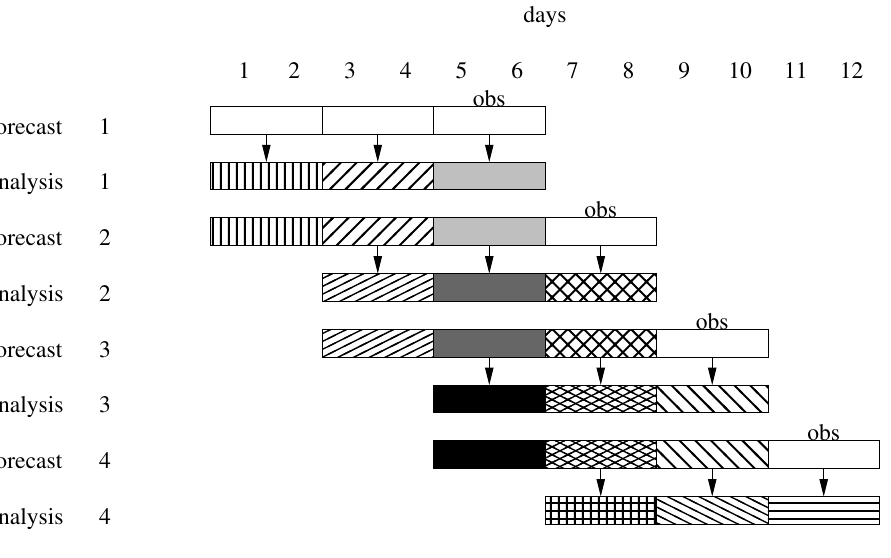
Figure 2. Schematic of the estimation of model parameters by the Kalman smoother. The forecast time evolution is shown along the horizontal direction, while the vertical direction indicates subsequent analyses. Vertical arrows represent the actual assimilation. Different colours represents different ensemble of parameter perturbations, constant over a finite time. The colour white indicates our initial ensemble. Here ∆ T = 6 days and ∆ t = 2